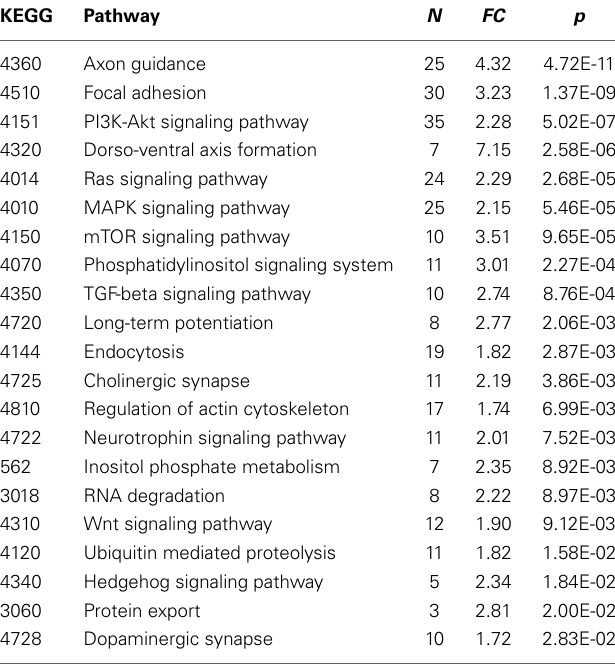
Table 1 | KEGG pathways targeted by the 13 activity-dependent